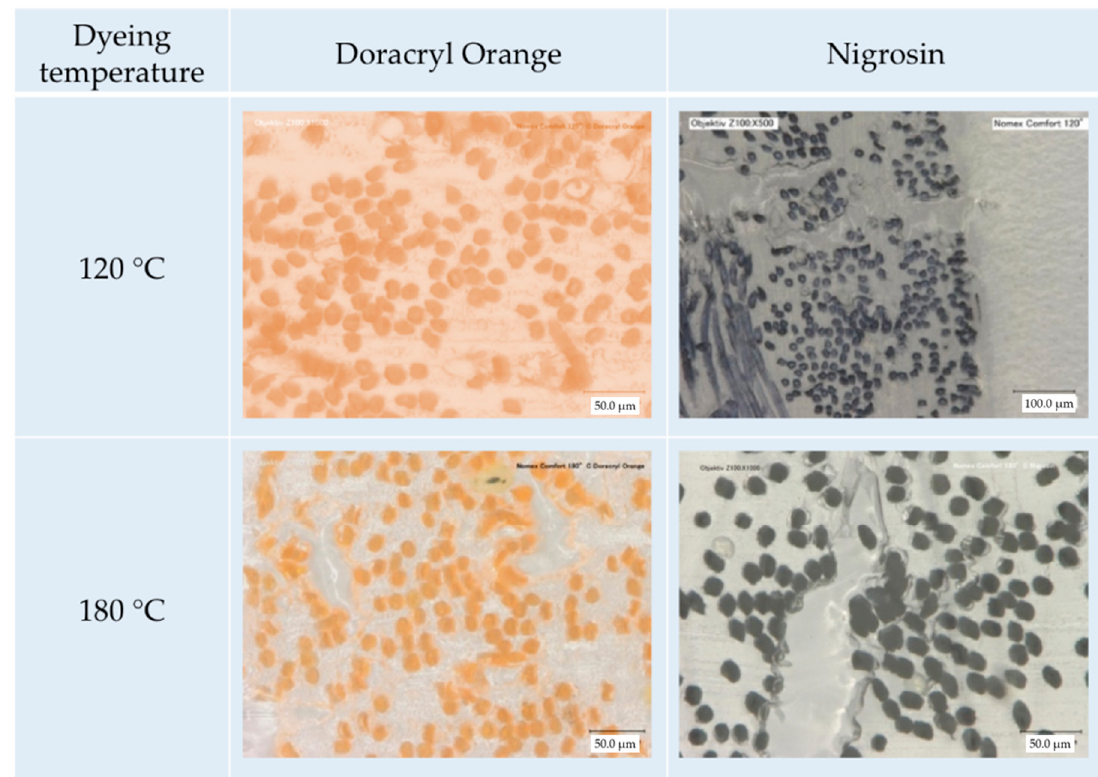
Figure 10. Fiber cross sections of amorphous m-aramid fabrics dyed with cationic dyestu ff Doracryl Orange and acid dyestu ff Nigrosin in EMIM-EtSO 4 at 120 ◦ C and 180 ◦ C, respectively. Polymers 2020 , 12 , x FOR PEER REVIEW